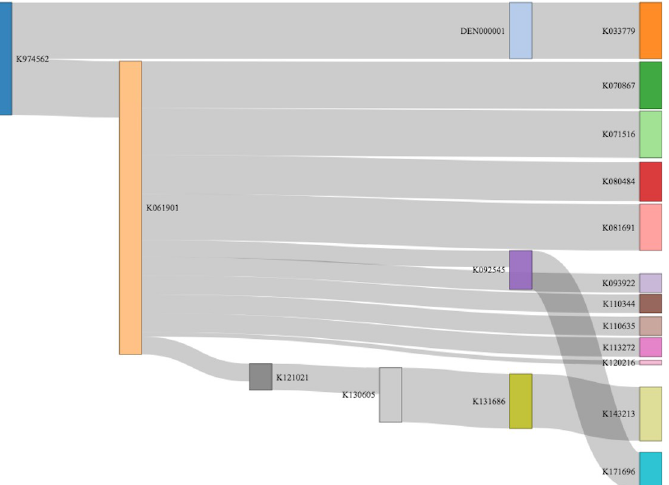
Fig 5. Sankey plot showing the genealogy of medical devices cleared through the 510(k) approach for a De Novo product DEN000001 (which was initially cleared as K974562 and reclassified to a De Novo product with special controls). The thickness of the connecting edge corresponds to the similarity match between a predicate and a successive device (the exceptions being the incoming/outgoing connections for the product K033779, for which summary statements are not